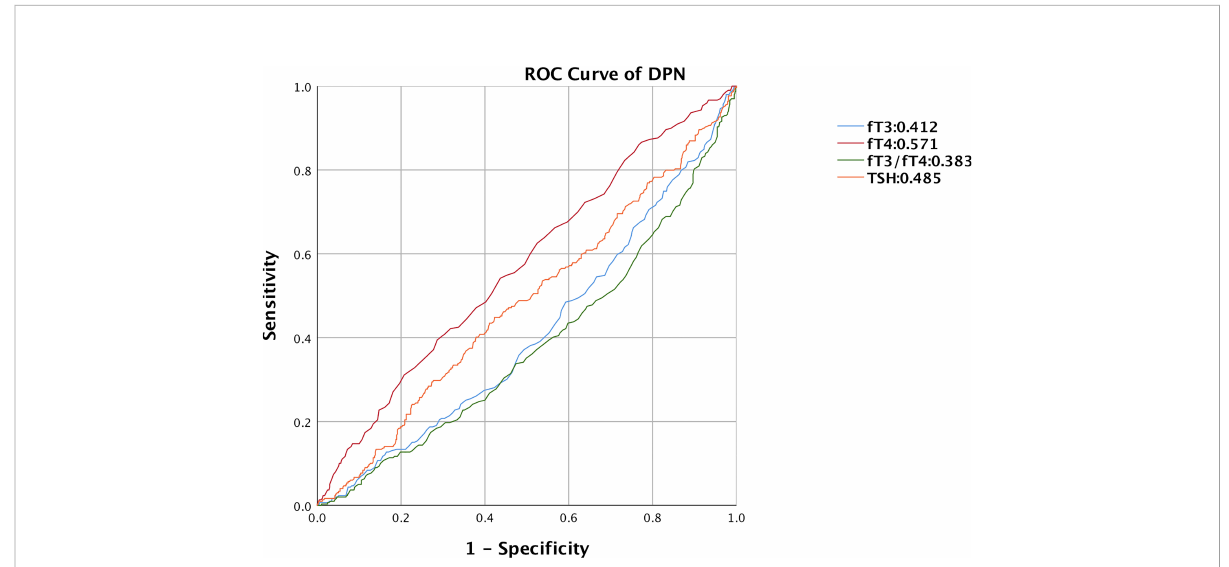
FIGURE 3 ROC curve of thyroid-related hormones predicting DPN in T2DM with euthyroid. ROC, receiver operating characteristic; DPN, diabetic peripheral neuropathy; fT3, free triiodothyronine1; fT4, free thyroxine; TSH, thyroid stimulating